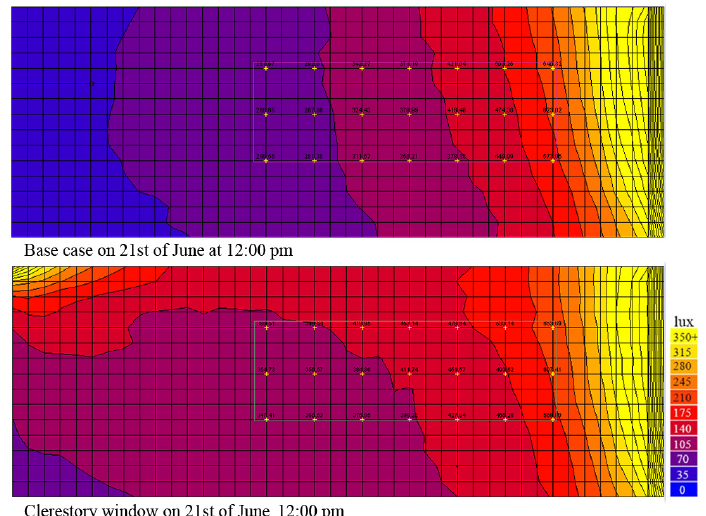
Figure 14. Illuminance levels and distribution on the vertical plane (by Radiance).